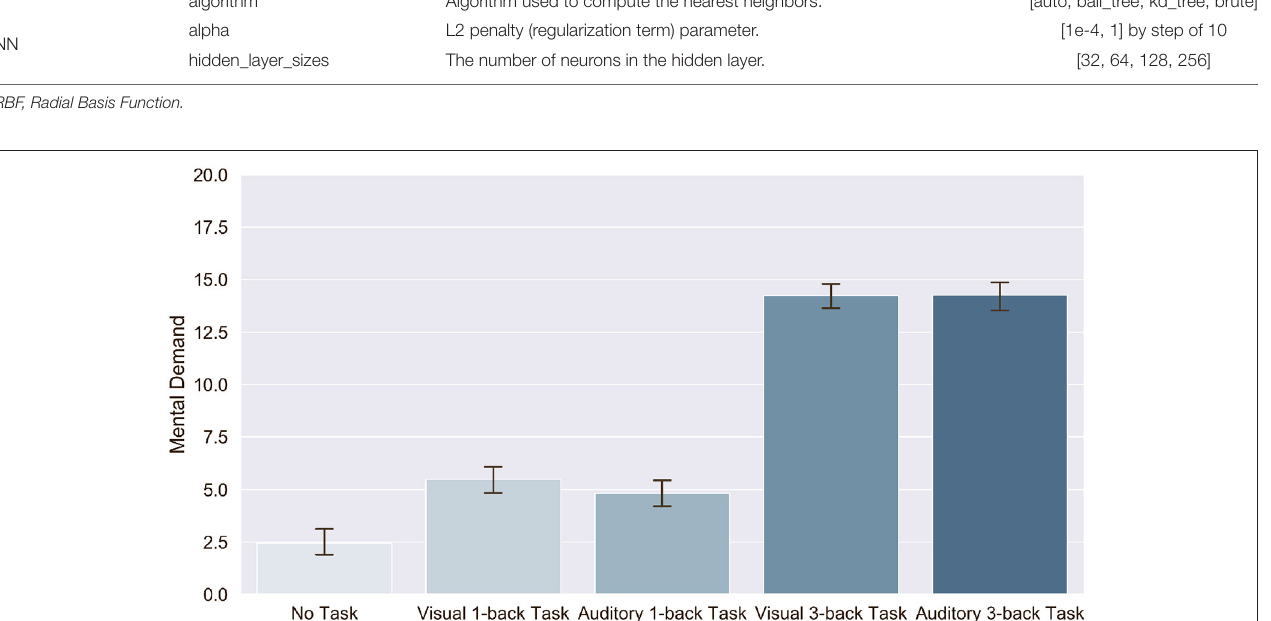
FIGURE 6 | Effect of task modality and difficulty on subjective ratings of mental demand reported after each sequence of N-back task.